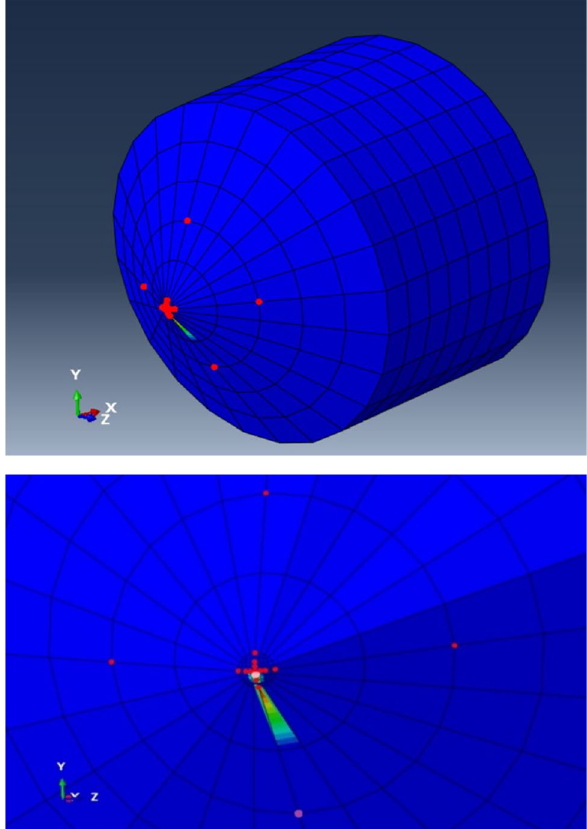
Fig. 12 Stinger cutter nodes used for the analysis (pink dot indicates the location with the highest temperature and violet dot is node with the highest